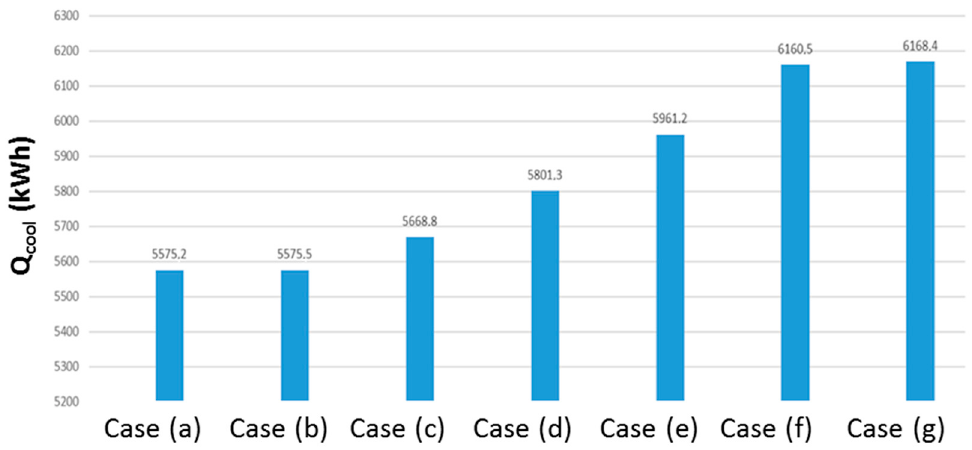
Figure 5. Annual cooling loads for the examined cases.